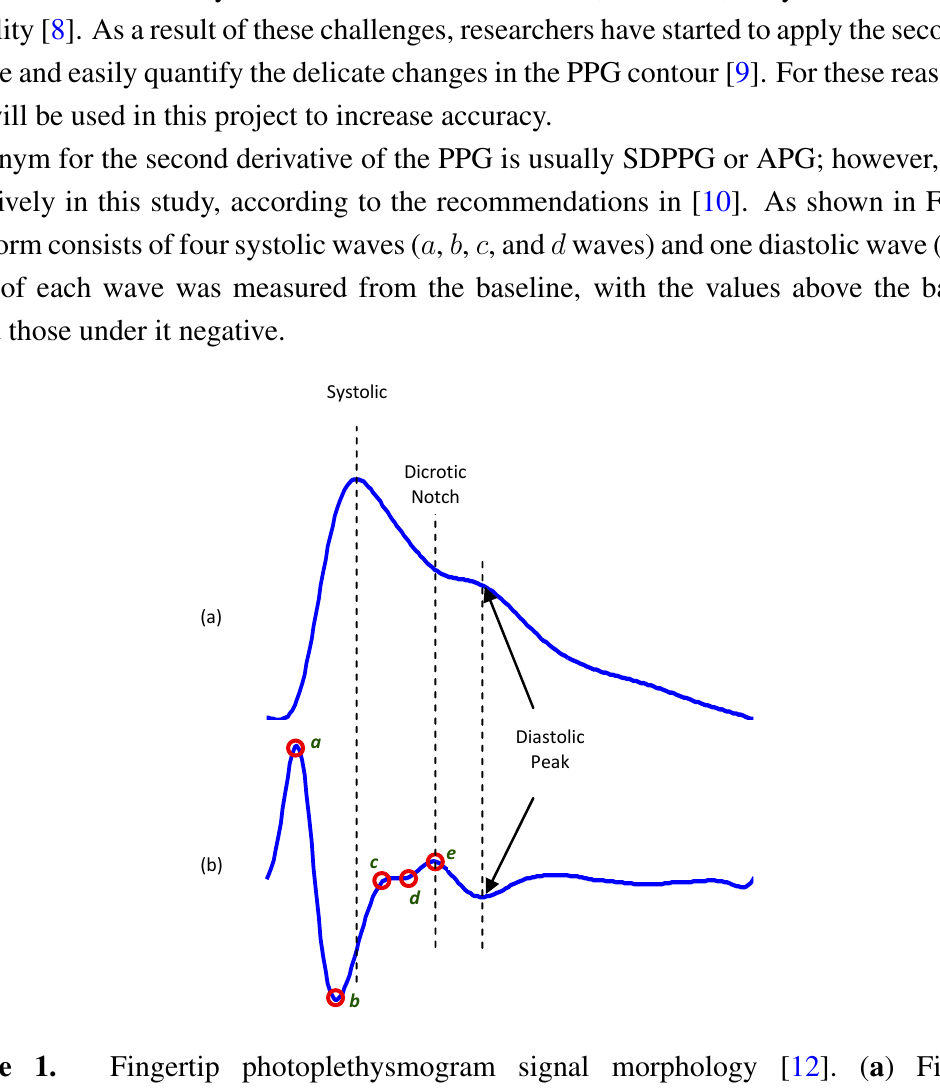
Figure 1. Fingertip photoplethysmogram signal morphology [12]. ( a ) Fingertip photoplethysmogram; ( b ) second derivative wave of photoplethysmogram.